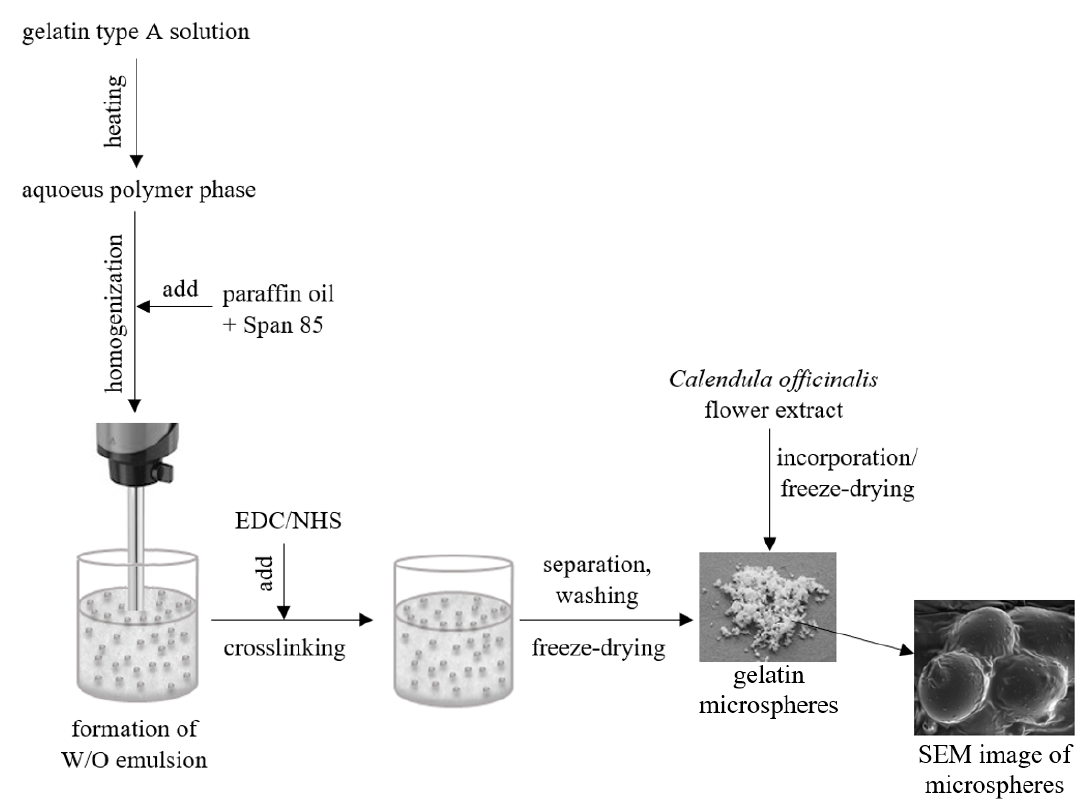
Figure 1. The scheme of production of gelatin microspheres loaded with Calendula officinalis flower extract.